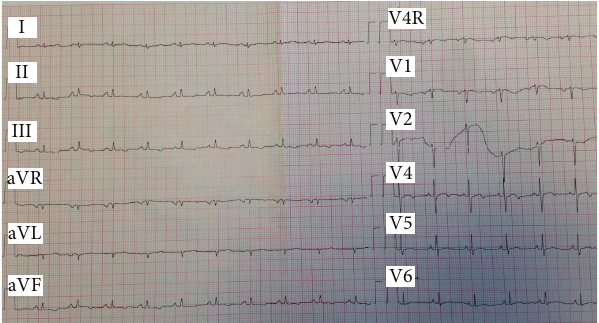
Figure2:Twelve-leadelectrocardiogram:heartrateof90 beats/min; low voltage QRS in frontal leads; nonspecific alterations of ventric- ular